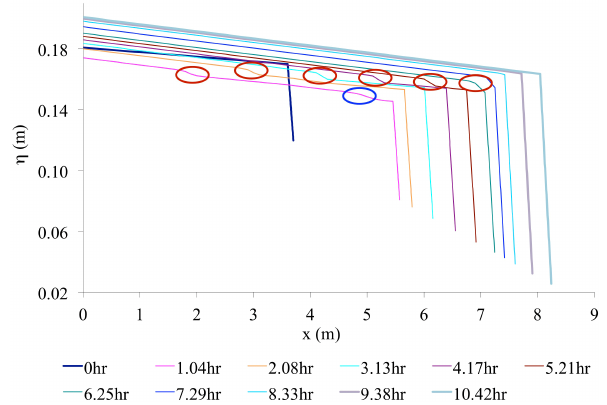
Figure A1. Temporal evolution of the longitudinal profile of delta elevation. The blue and red blue ovals respectively denote the loca- tion of the first and second small delta fronts. Time=0h denotes the model initial condition. The results are obtained using the Ashida and Michiue grain-size-based bedload relation, which is not appro- priate for modeling the Ferrer-Boix et al. (2013)